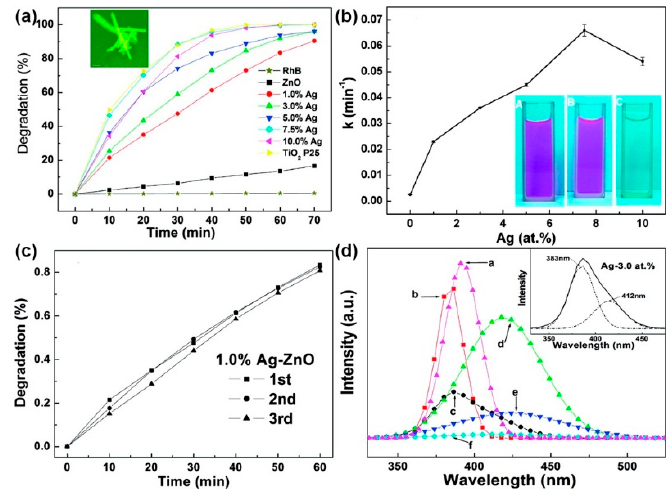
Figure 5. ( a ) Kinetics of the photodegradation of RhB by Ag/ZnO nanoparticles; ( b ) The degradation rate constant versus the Ag loading content; ( c ) Photodegradation of RhB by Ag/ZnO nanoparticles for three cycles; ( d ) PL spectra of the Ag/ZnO nanofibers with various Ag loading contents ((a) pure ZnO, (b) 1 atom% Ag, (c) 3 atom% Ag, (d) 5 atom% Ag, (e) 7.5 atom% Ag, (f) 10 atom% Ag). Reproduced from [79], with copyright permission from American Chemical Society, 2009.